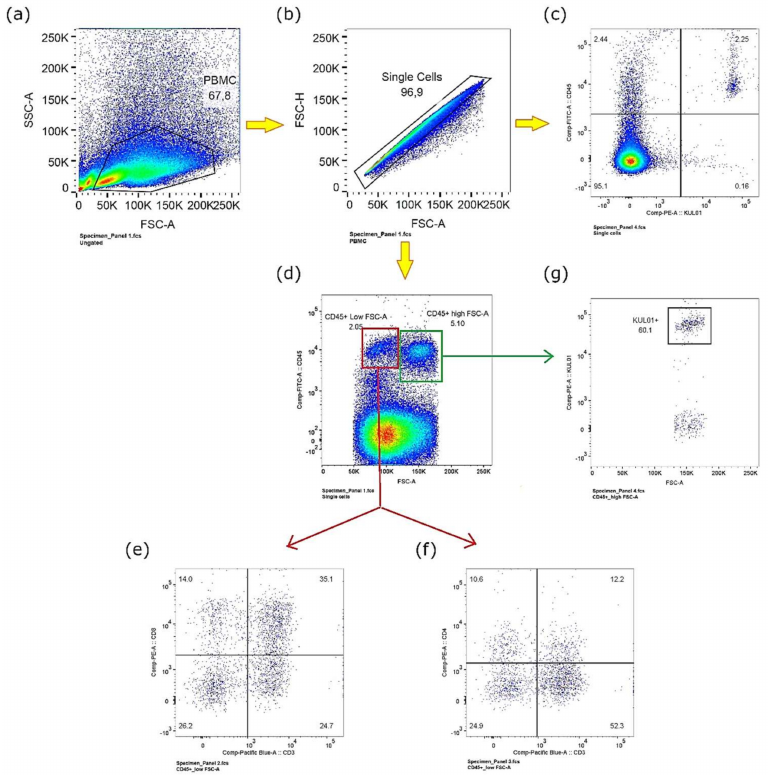
Figure 1. Immunophenotyping on Chicken Peripheral Blood Mononuclear Cells: ( a ) PBMCs were gated based on FSC and SSC; ( b ) Singlet cells were selected from gated PBMCs; ( c ) Monocytes were identified within singlet gated PBMCs through labeling with fluorochrome-conjugated anti- chicken CD45 and anti-chicken KUL01 antibodies; ( d ) Two cell subsets were observed with CD45 + cells, FSC-low or FSC-high; ( e ) CD8 + lymphocytes and ( f ) CD4 + lymphocytes were identified with CD45 + /FSC-low population; ( g ) Monocytes clustered more in CD45 + /FSC-high